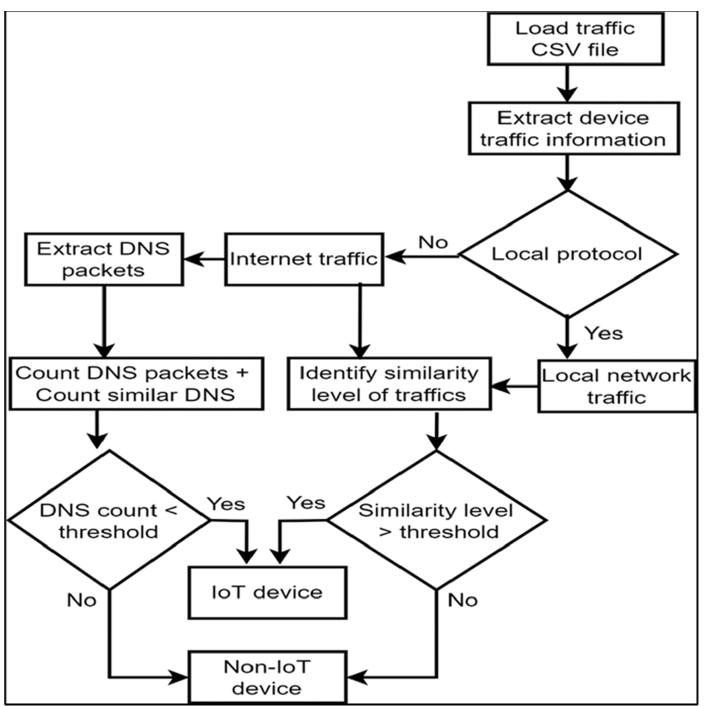
Figure 8. Model for distinguishing between IoT devices and non-IoT devices.